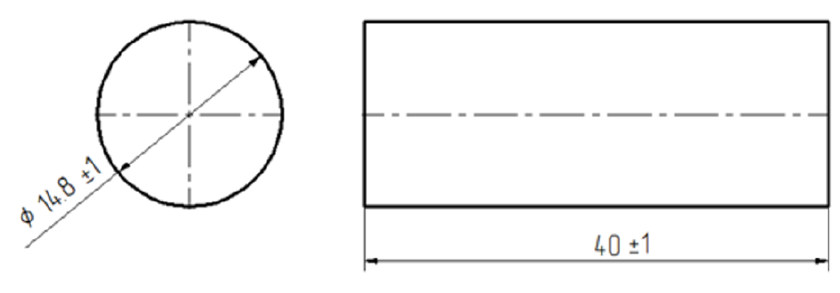
Figure 1. Dimensions [mm] of adhesives sample.